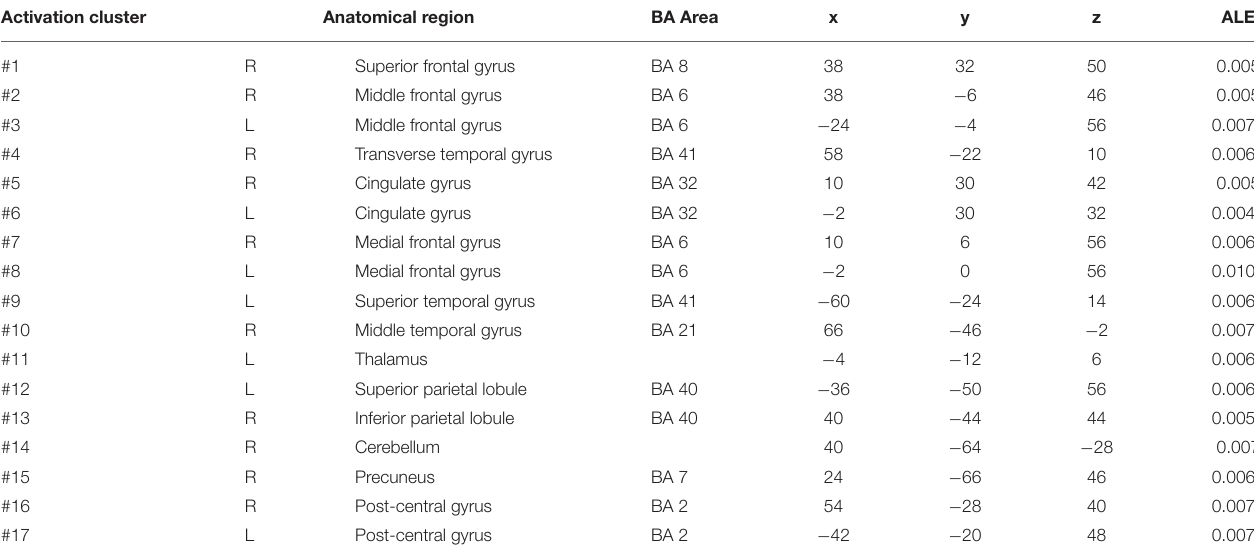
TABLE 2 | Clusters of activation in self-priming conditions in the PD patients. Activation